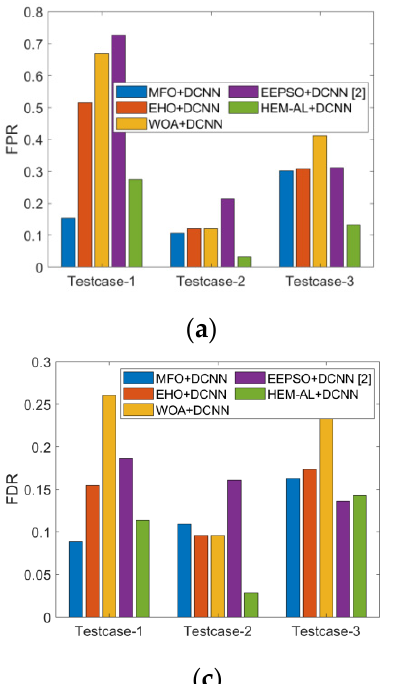
Figure 5. Performance of the developed scheme over extant schemes for “( a ) FPR ( b ) FNR ( c ) FDR”.